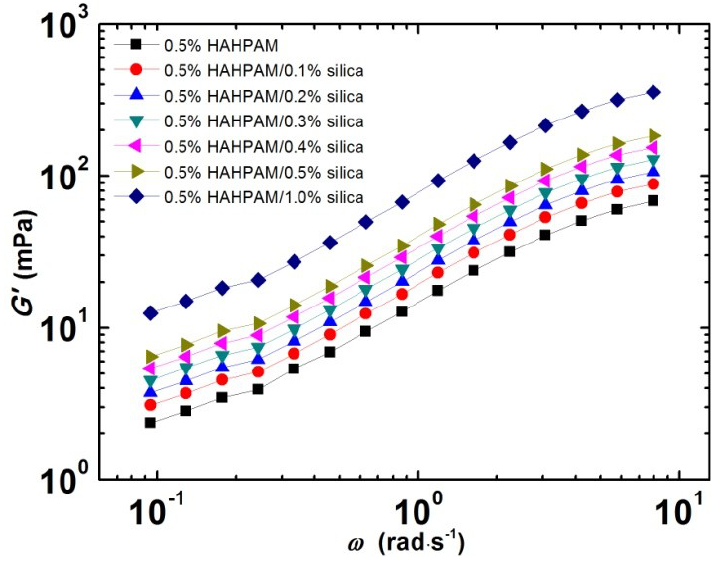
Figure 5. Storage modulus ( G′ ) plotted as a function of angular frequency ( ω ) for HAHPAM/silica hybrids in brine with different silica loading (TDS = 32,868 mg∙L −1